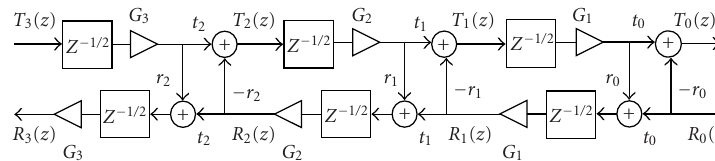
Figure 3: Signal flow diagram for three stages of an active optical lattice